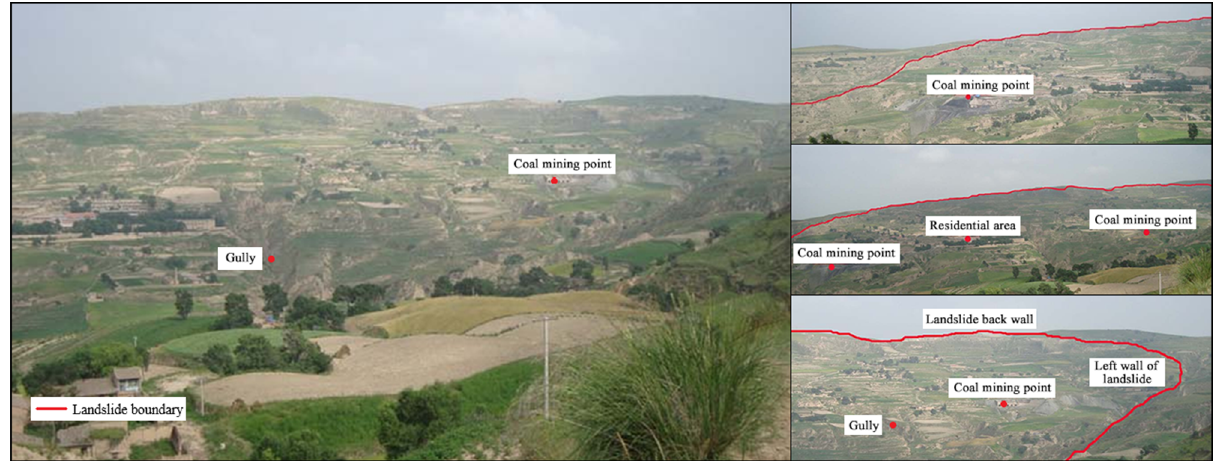
Figure 1. The shape of landslide in the Tanshan Coal Mine.